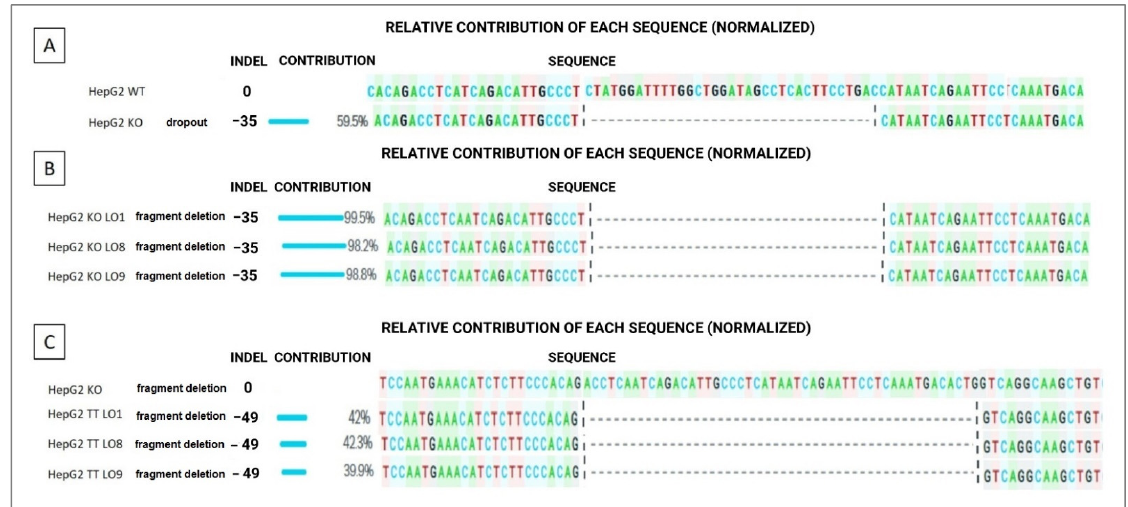
Figure 2. Sequencing of the different editing procedures performed in the F5 of the HepG2 cell line. ( A ) Editing efficiency of the WT HepG2 line for obtaining the KO HepG2 line (by deleting 35 bp). ( B ) Three clone KO HepG2 cell lines (LO1, LO8 and LO9) were homozygous for the deletion of 35 bp, giving rise to the formation of a codon stop. ( C ) Editing efficiency of the KO clones for canceling the mutation and restoring the gene’s frameshift, giving rise to a corrected TT HepG2 cell line. Indel: insertion/deletion. Analyses were developed with the online version of Synthego’s ICE